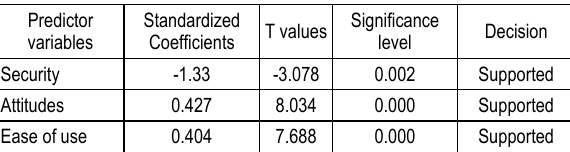
Table 3. Regression